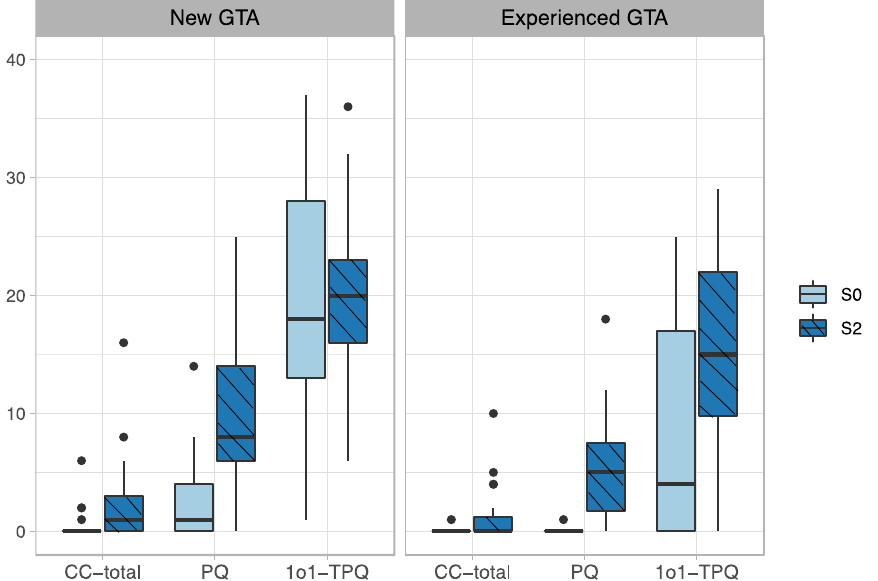
FIG. 9. Frequencies of questioning-related skills implemented by GTAs with and without teaching experience in semester 0 and semester 2. For both new and experienced GTAs, the average frequencies of CC-total and PQ increased in semester 2, with medium and large effect size,